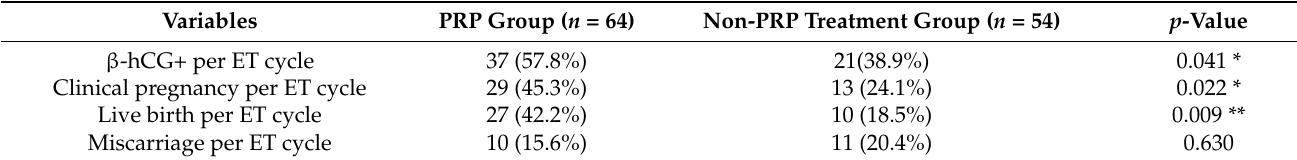
Table 4. Comparison of outcome